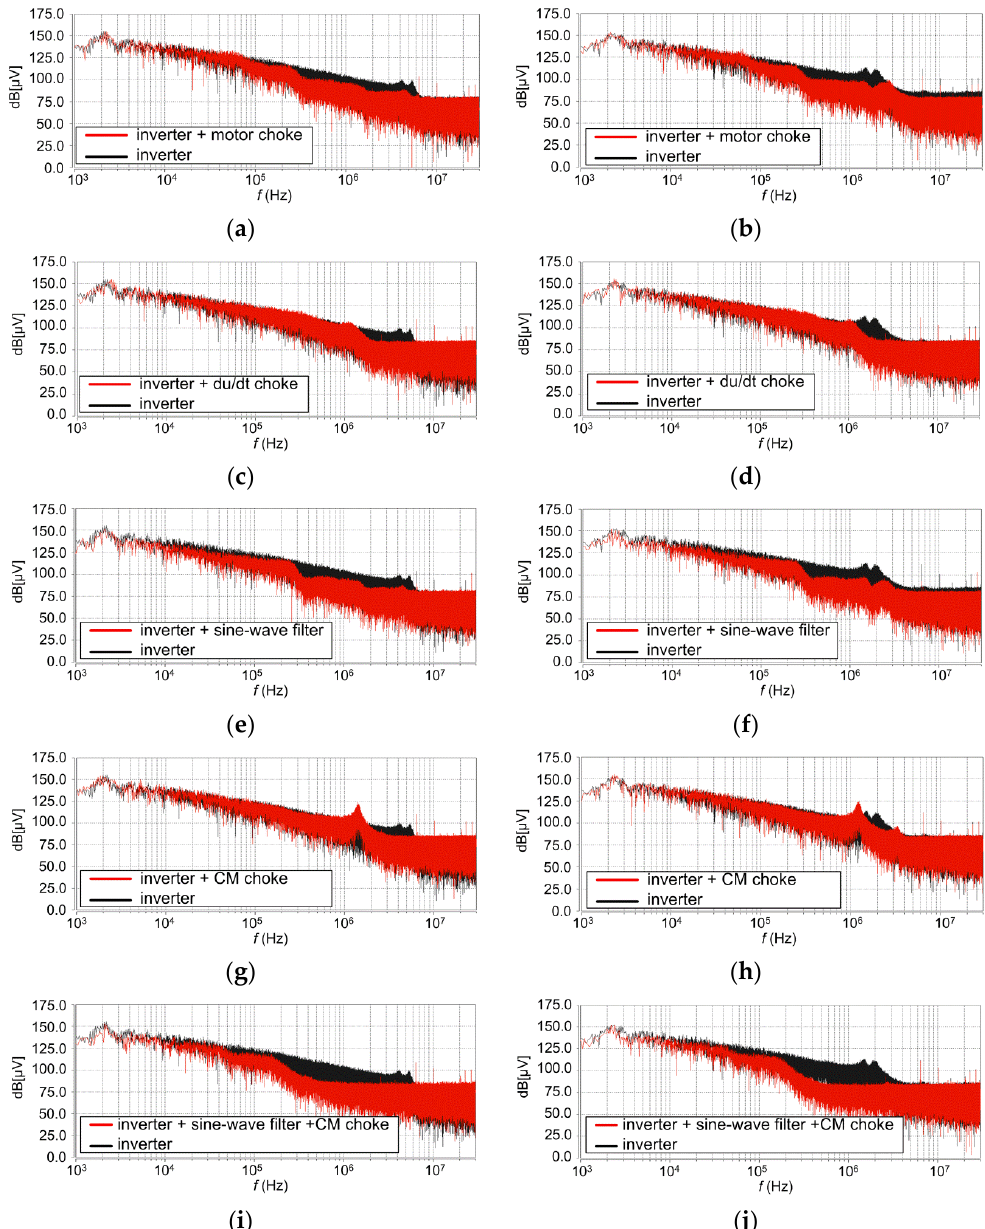
Figure 21. Spectrum of voltage u C_PE recorded in a configuration with: ( a , c , e , g , i ) 1 m cable; ( b , d , f , h , j ) 10 m cable.